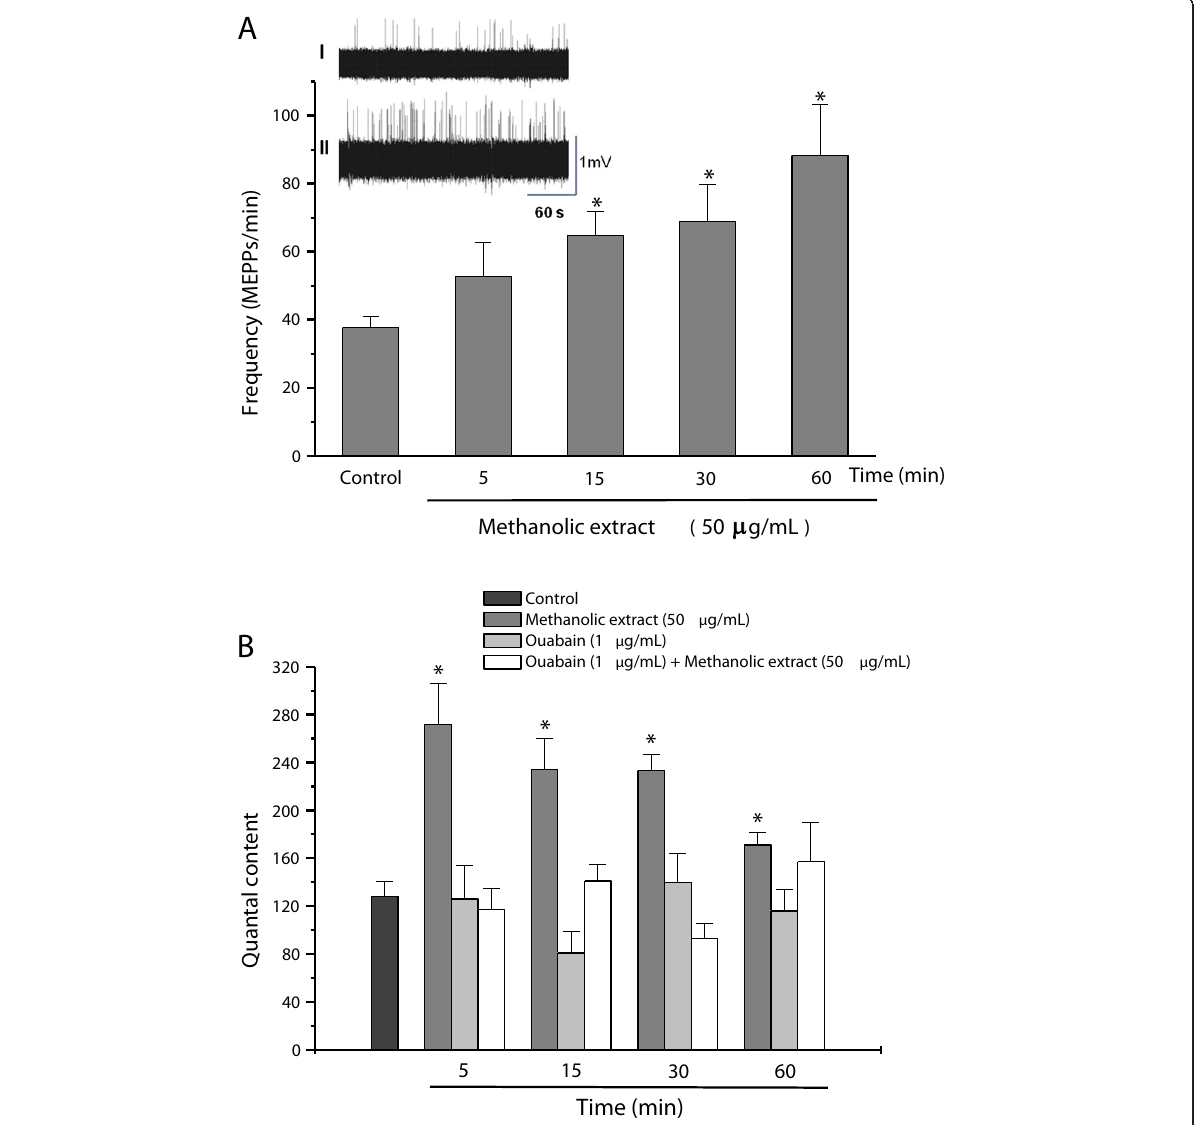
Figure 2 Electrofisiological measurements in PND preparations. (A) Changes in the frequency of miniature end-plate potentials (MEPPs) in phrenic nerve-diaphragm preparations incubated with a methanolic extract of R. schneideri venom (50 μ g/mL). Insets I and II in A : recordings at time zero (0) and after incubation with extract for 60 minutes, respectively. (B) Changes in the quantal content (end-plate potentials) of phrenic nerve-diaphragm preparations incubated with a methanolic extract of R. schneideri venom (50 μ g/mL) for up to 60 minutes and the effect of pretreatment with ouabain (1 μ g/mL). The columns are the mean ± S.E.M. (n = 5), * p < 0.05 compared to control